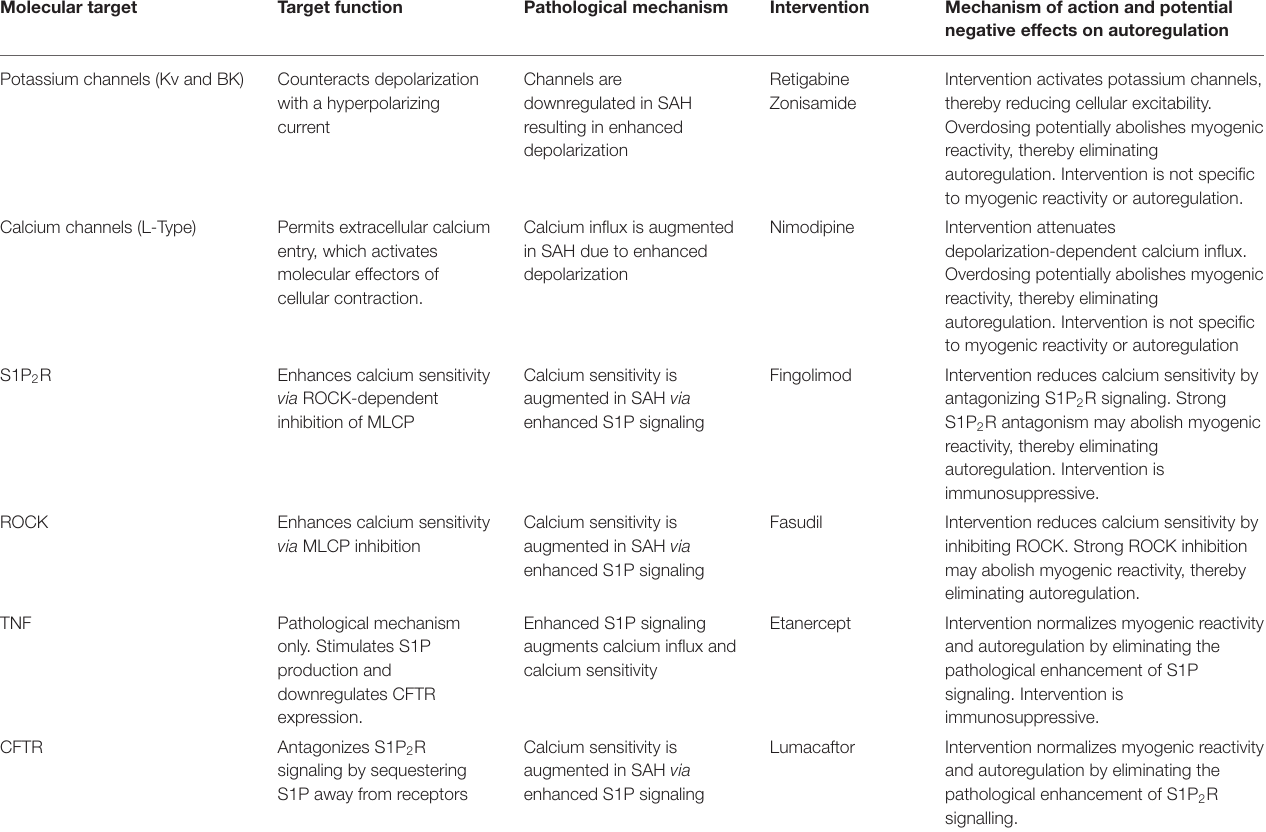
TABLE 8 | Potential interventions for treating dysfunctional autoregulation in subarachnoid